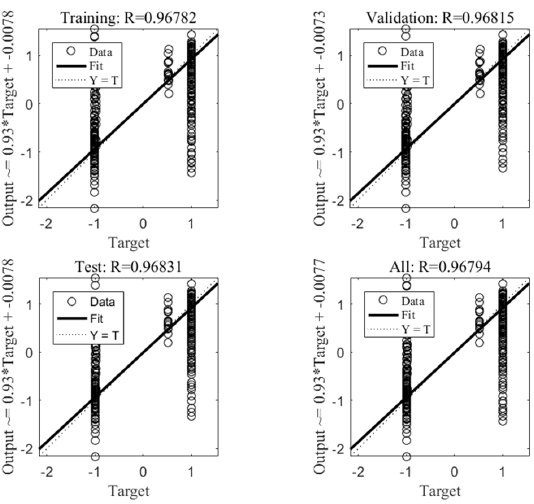
Figure 14. Deep Neural Network Training Results.